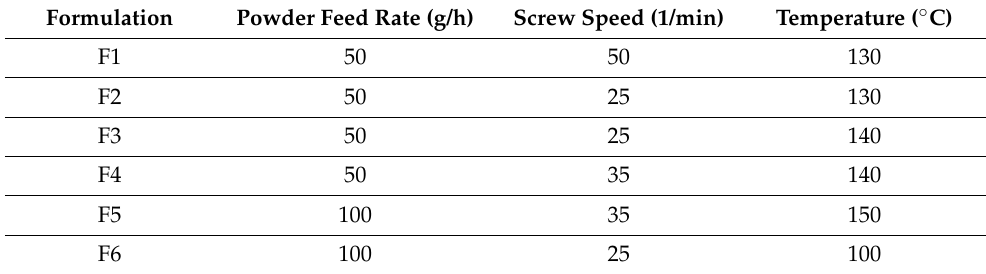
Table 2. Process parameters for HME for the different formulations.